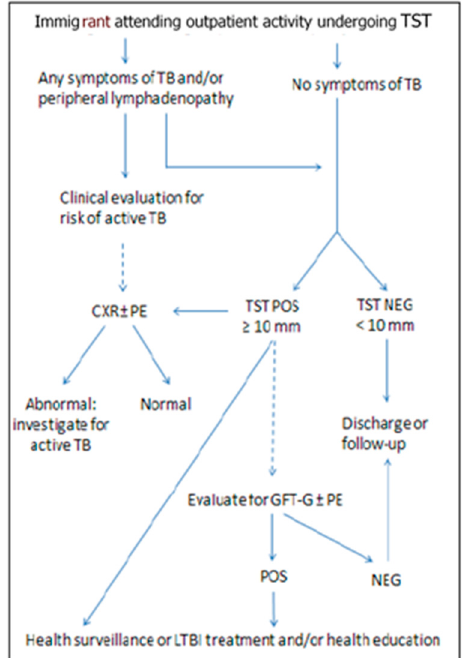
Figure 1. Procedures for active tuberculosis ( TB ) and latent tuberculosis infection ( LTBI ) screening at the Centre for Health of Foreign Family ( CFF ) of Reggio Emilia. TST : Tuberculin Skin Test; CXR: chest X-ray; PE: Pneumological Examination; POS: positive; NEG: negative.